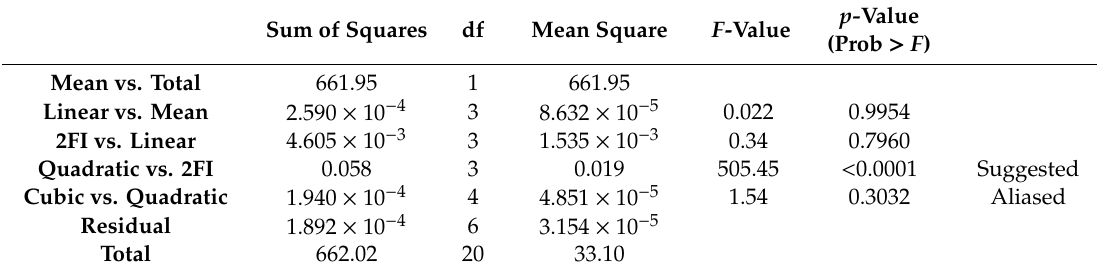
Table 2. A sequential model sum of squares.